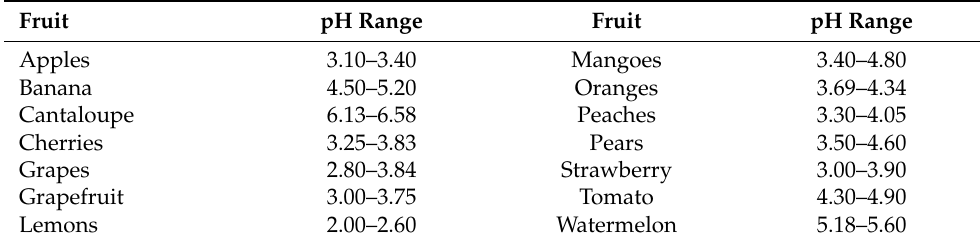
Table 2. pH of Ripe Fruit